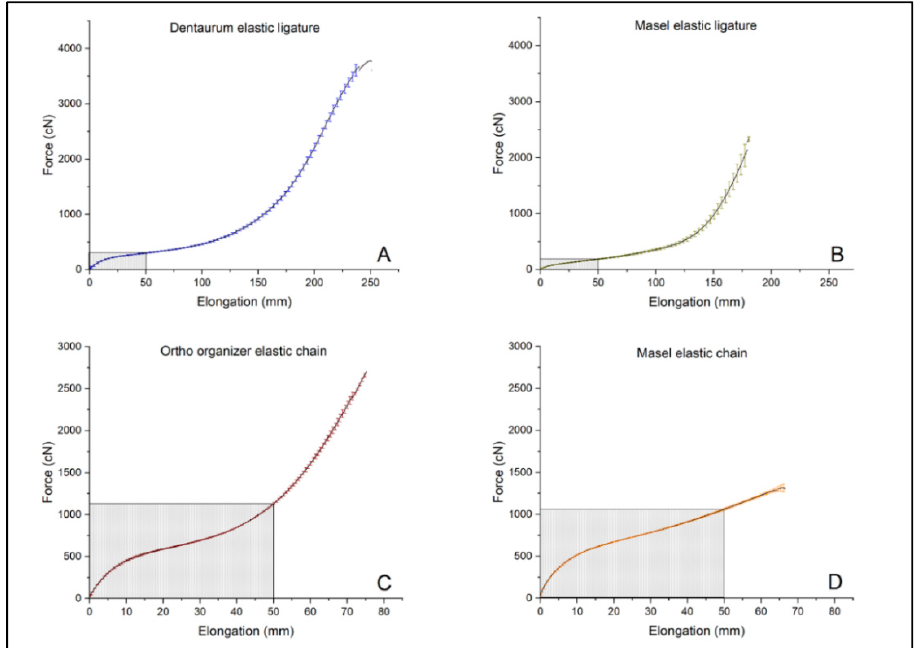
Figure 3. Tensile strength of untreated, intact ( A ) Dentaurum elastic ligature, ( B ) Masel elastic ligature, ( C ) Ortho organizer elastic chain, ( D ) Masel elastic chain. Shaded rectangles indicate the range of their general usage based on clinical experience ( n = 3/elastomer).